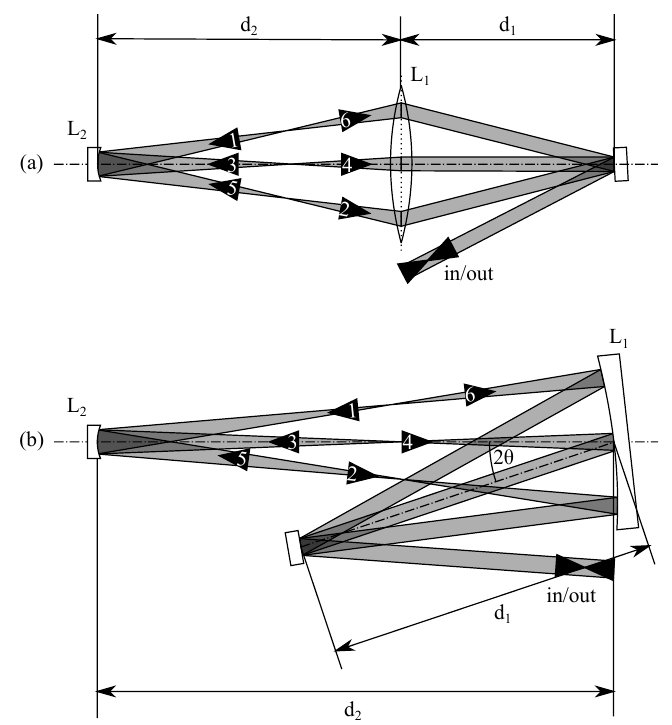
Figure 2. Schematic drawings of Type II systems with three round-trips based on lenses ( a ) and on mirrors ( b ) as imaging elements. The numbers in the arrows denote the sequence of passing